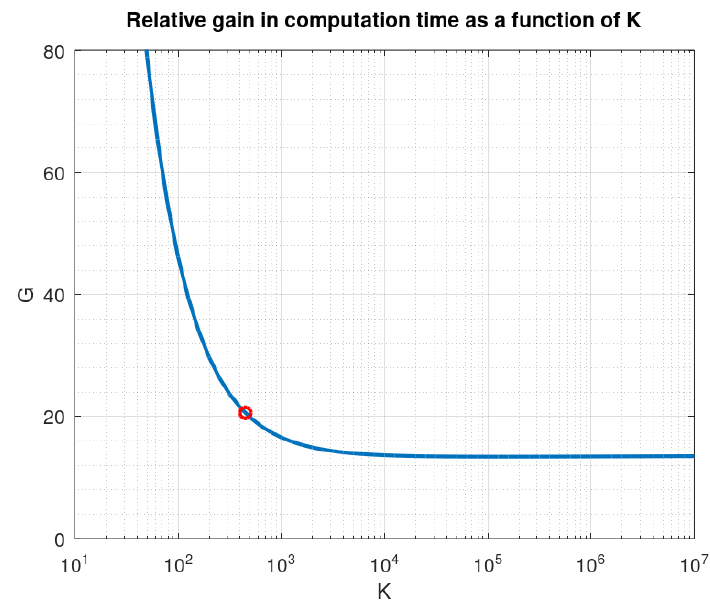
Figure 11. Gain as a function of K (the red dot shows the values corresponding to our acquisition board).